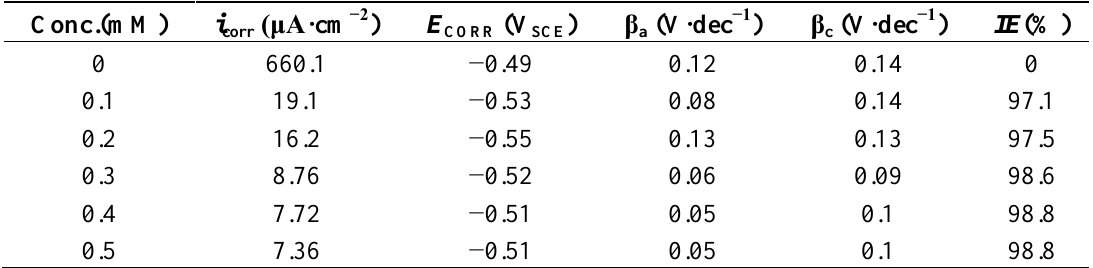
Table 1. Polarization parameters for mild steel in 1.0 M HCl with different concentrations of the PMBH at 30